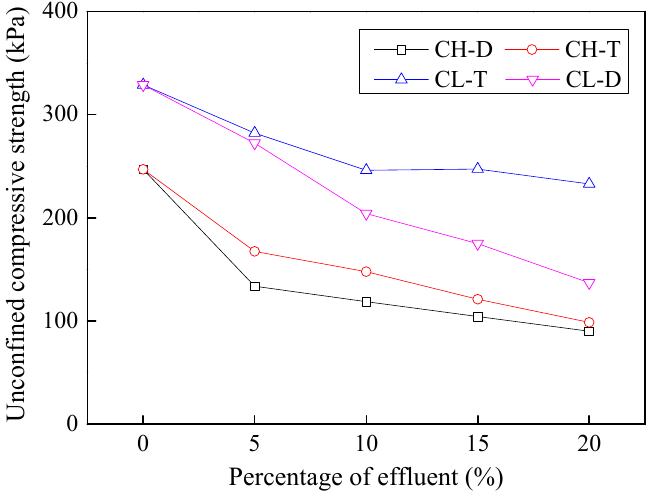
Figure 10. Effects of industrial effluents on unconfined compressive strength of cohesive soils.